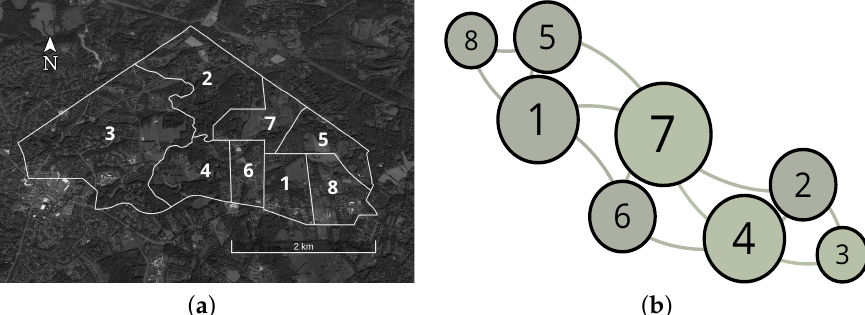
Figure 2. ( a ) Our region is divided in different polygons by census tracts. Each polygon is numbered to facilitate its identification. ( b ) Each node corresponds to a polygon with the same identification number as the figure on the left. Edges link overlapping polygons from the previous illustration. Node sizes are related to their